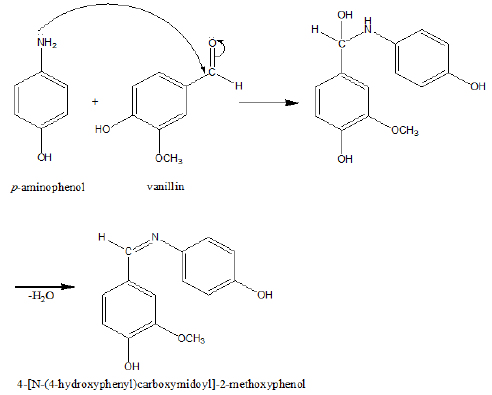
Figure 1. Nucleophilic addition of amine in p - aminophenol and vanillin, forming imine group in PAPVN structure In the LC-MS results, there was only one peak of compound at 2.41 min of the retention time, so it can be said that the synthesized compound was pure, free of residue and by product. From the determination of melting point, PAPVN has a melting point